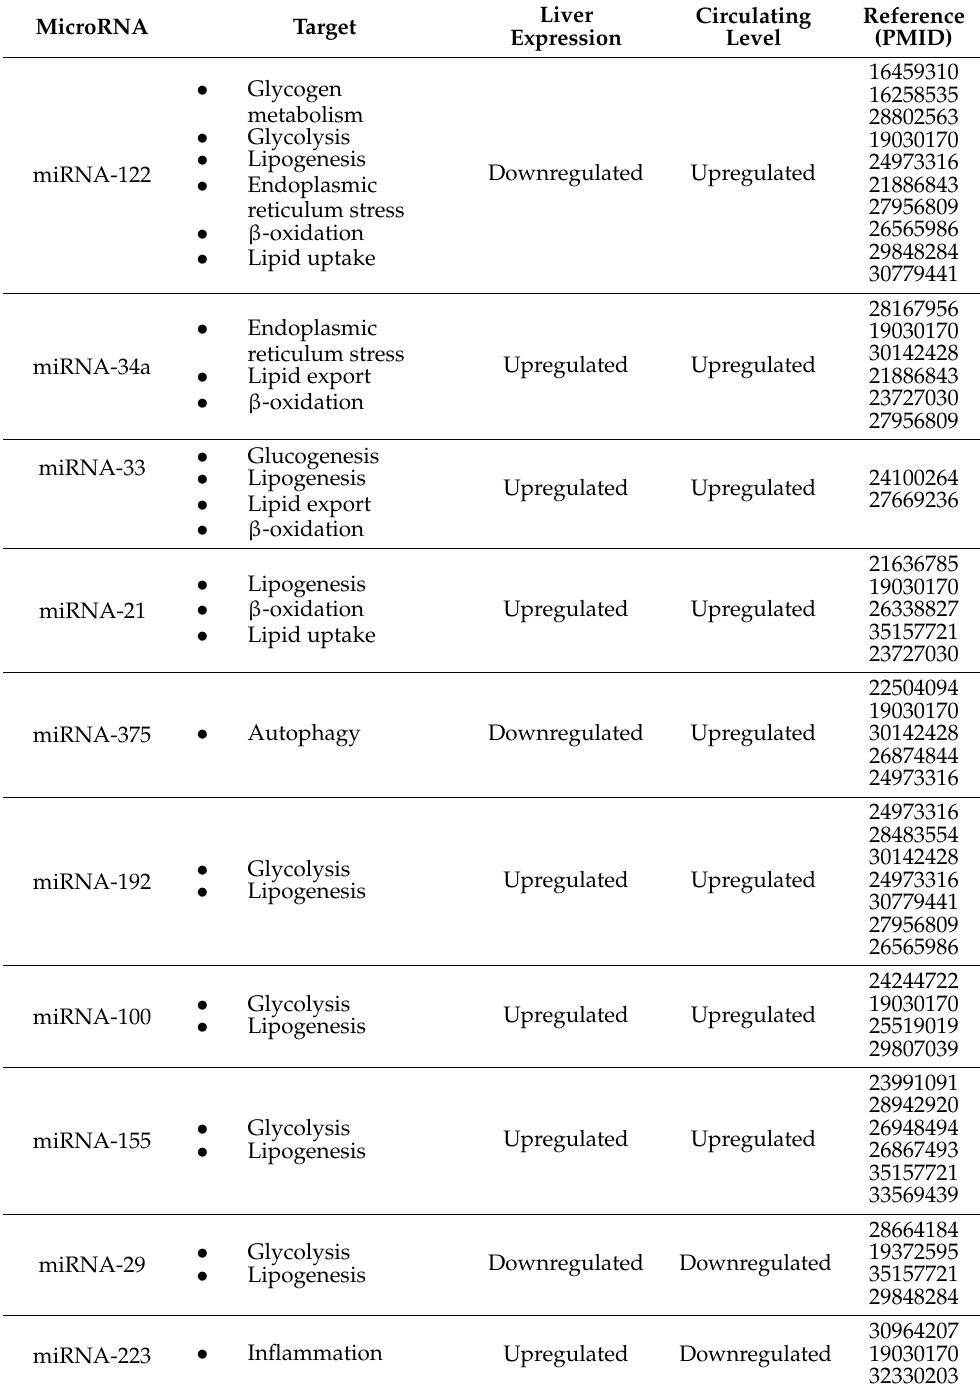
Table 1. Most relevant microRNAs implicated in liver metabolism and deregulated in liver